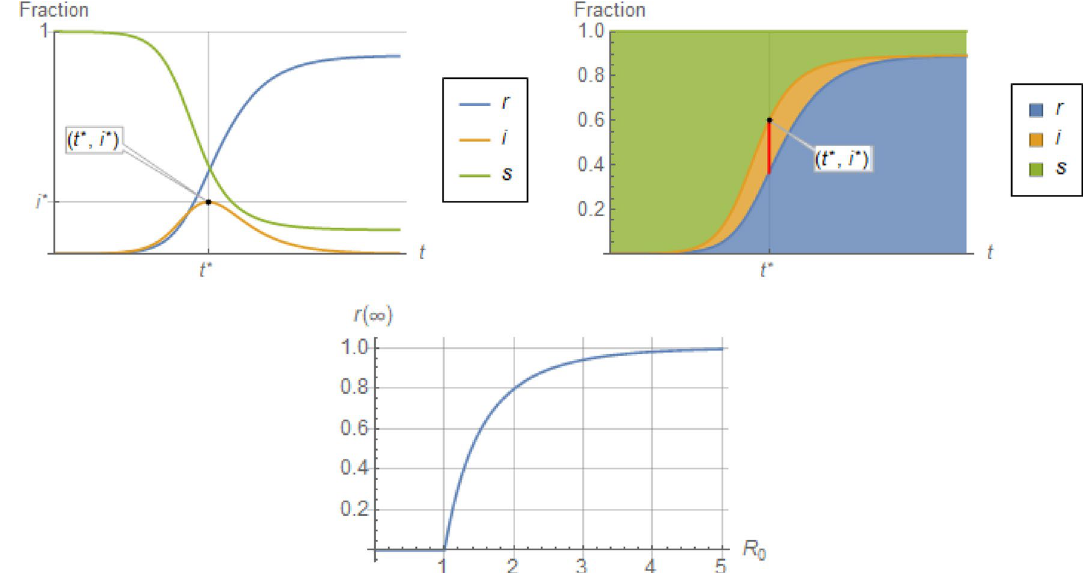
Figure 1. Top: Qualitative trends of individual (left) and stacked (right) profiles for s , i , r fractions of a population in a spreading epidemic, from initiation to termination. Bottom: Total fraction of a population infected by the end of an epidemic, r